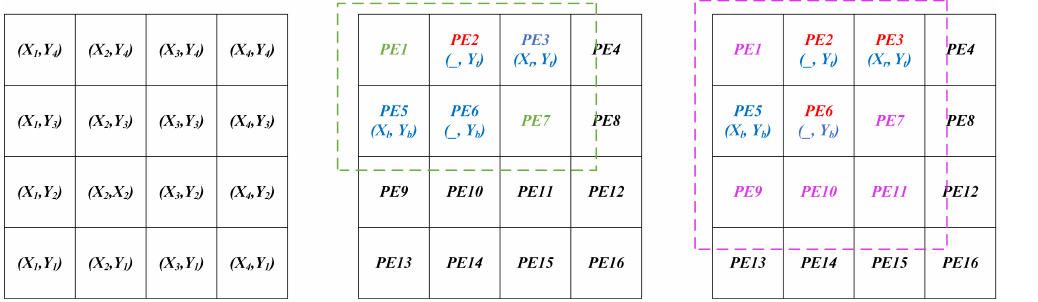
Figure 4. The effect of optimizing the evolvable region. (Red Color: the HT-I PEs; Blue Color: the coordinates of the leftmost, topmost, rightmost and bottommost PEs; Green and Pink Color: the effect of optimizing evolvable